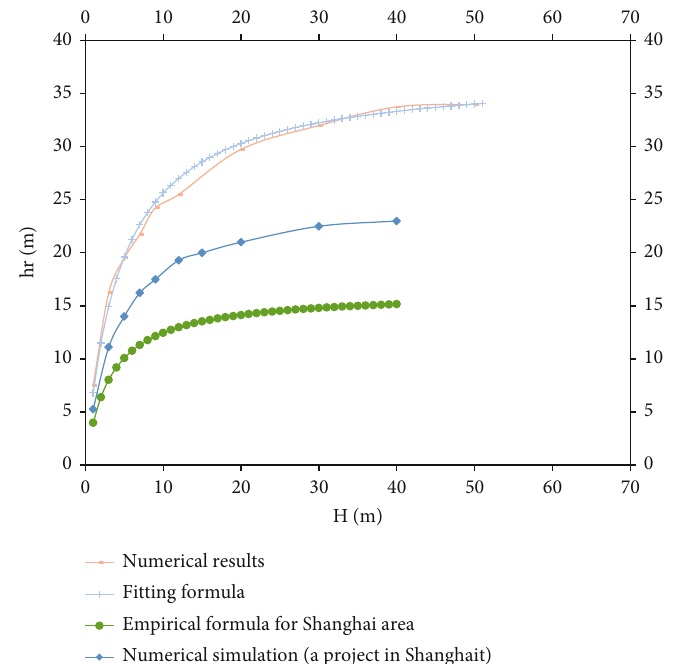
Figure 7: The comparison of unloading in fl uence depth of sand soil and soft